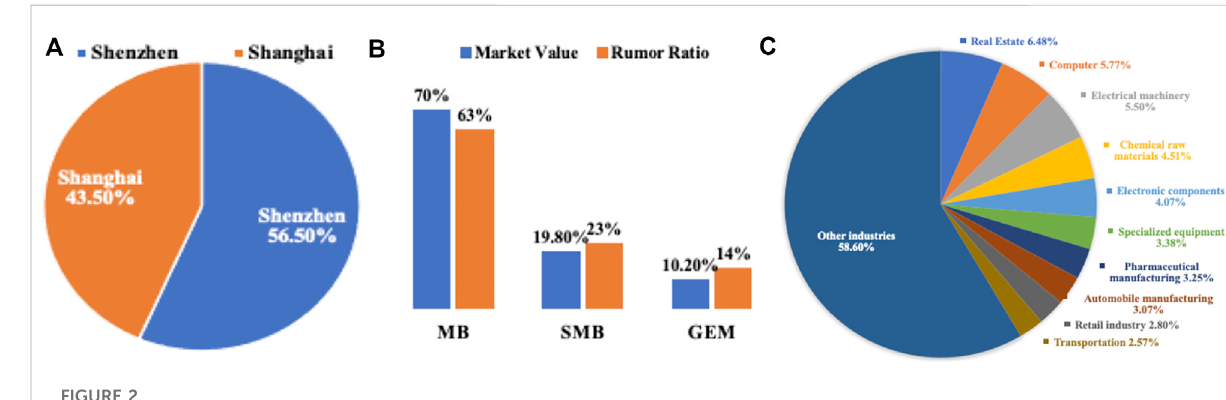
FIGURE 2 Distribution of trading venues, sectors and